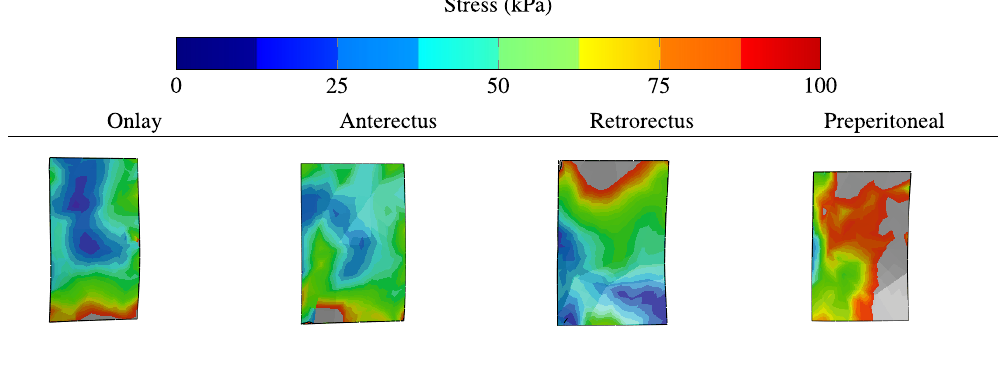
Figure 9. Equivalent stress distribution in the surgical mesh implants applied at the onlay, anterectus, retrorectus, or preperitoneal